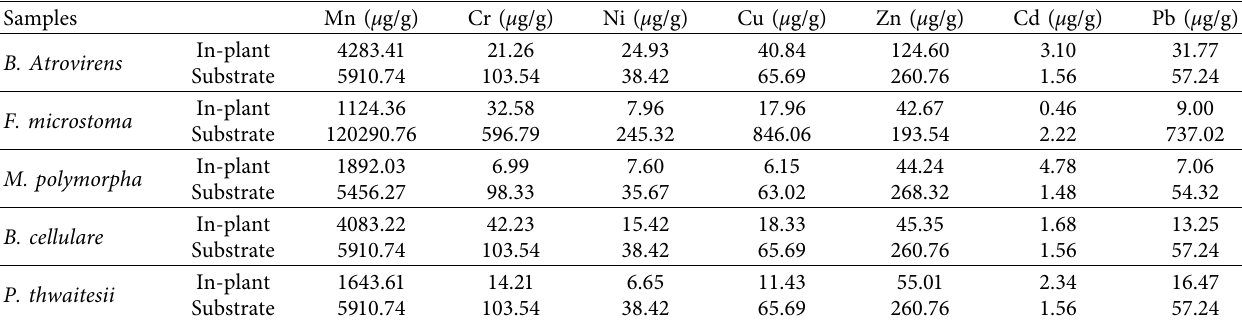
Table 10: Content of heavy metals in bryophytes and growth substrate from electrolytic manganese slag areas.